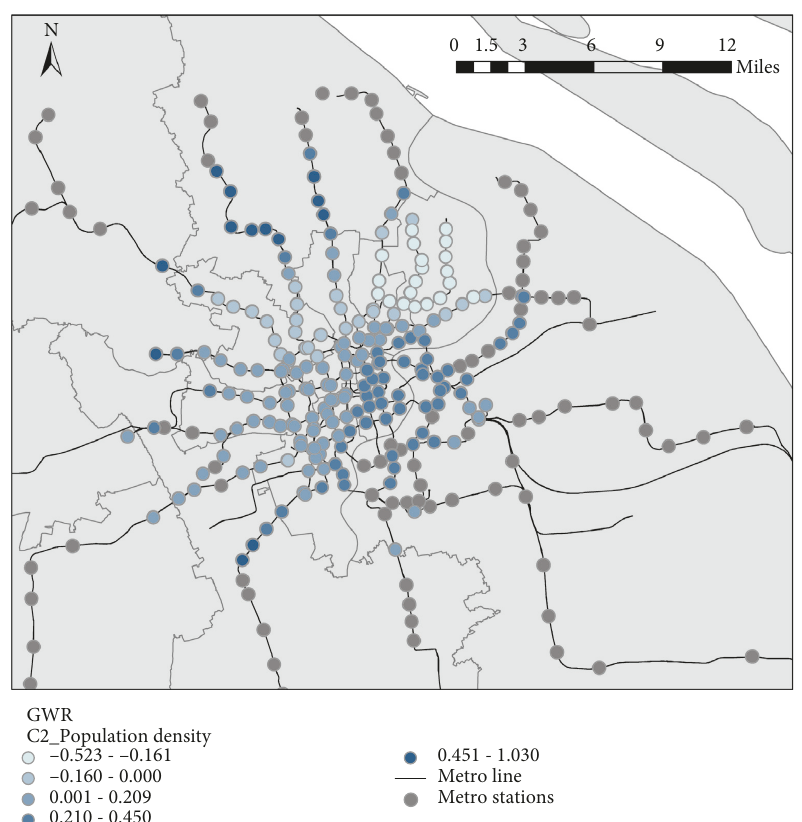
Figure 8: Spatially varying effect of the population density on bike-sharing transfer